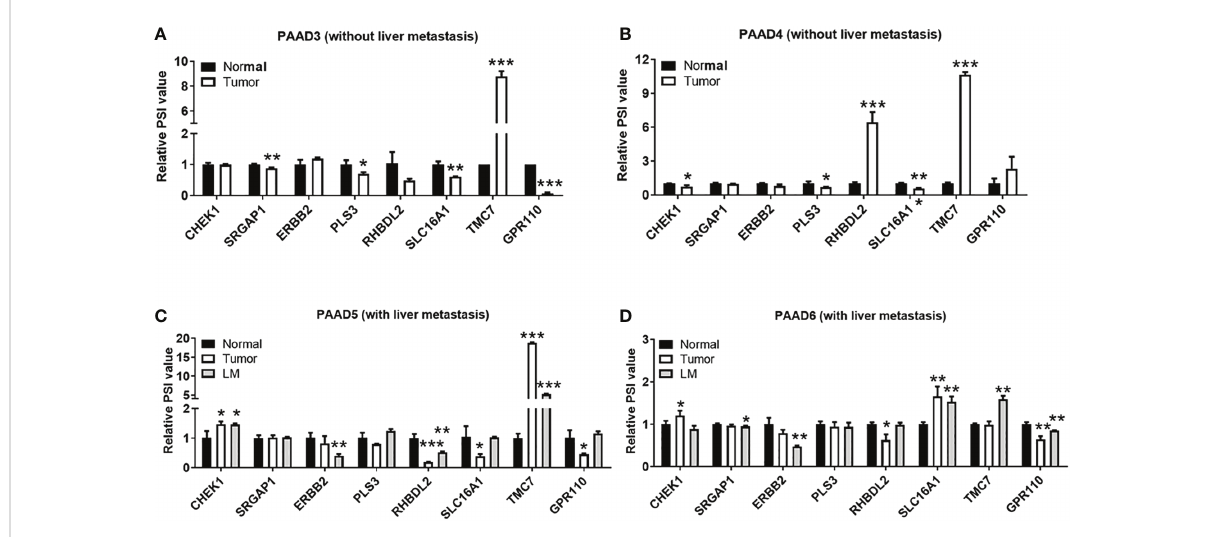
FIGURE 4 Validation of gene AS events associated with liver metastases in pancreatic cancer. By qRT-PCR analysis, expression of right gene AS events in pancreatic cancer tissues without liver metastases (A, B) n = 2 and pancreatic cancer with hepatic metastases (C, D) n = 2. AS, alternative splicing. P value, "*" 0.01-0.05; "**" 0.001-0.01; "***"